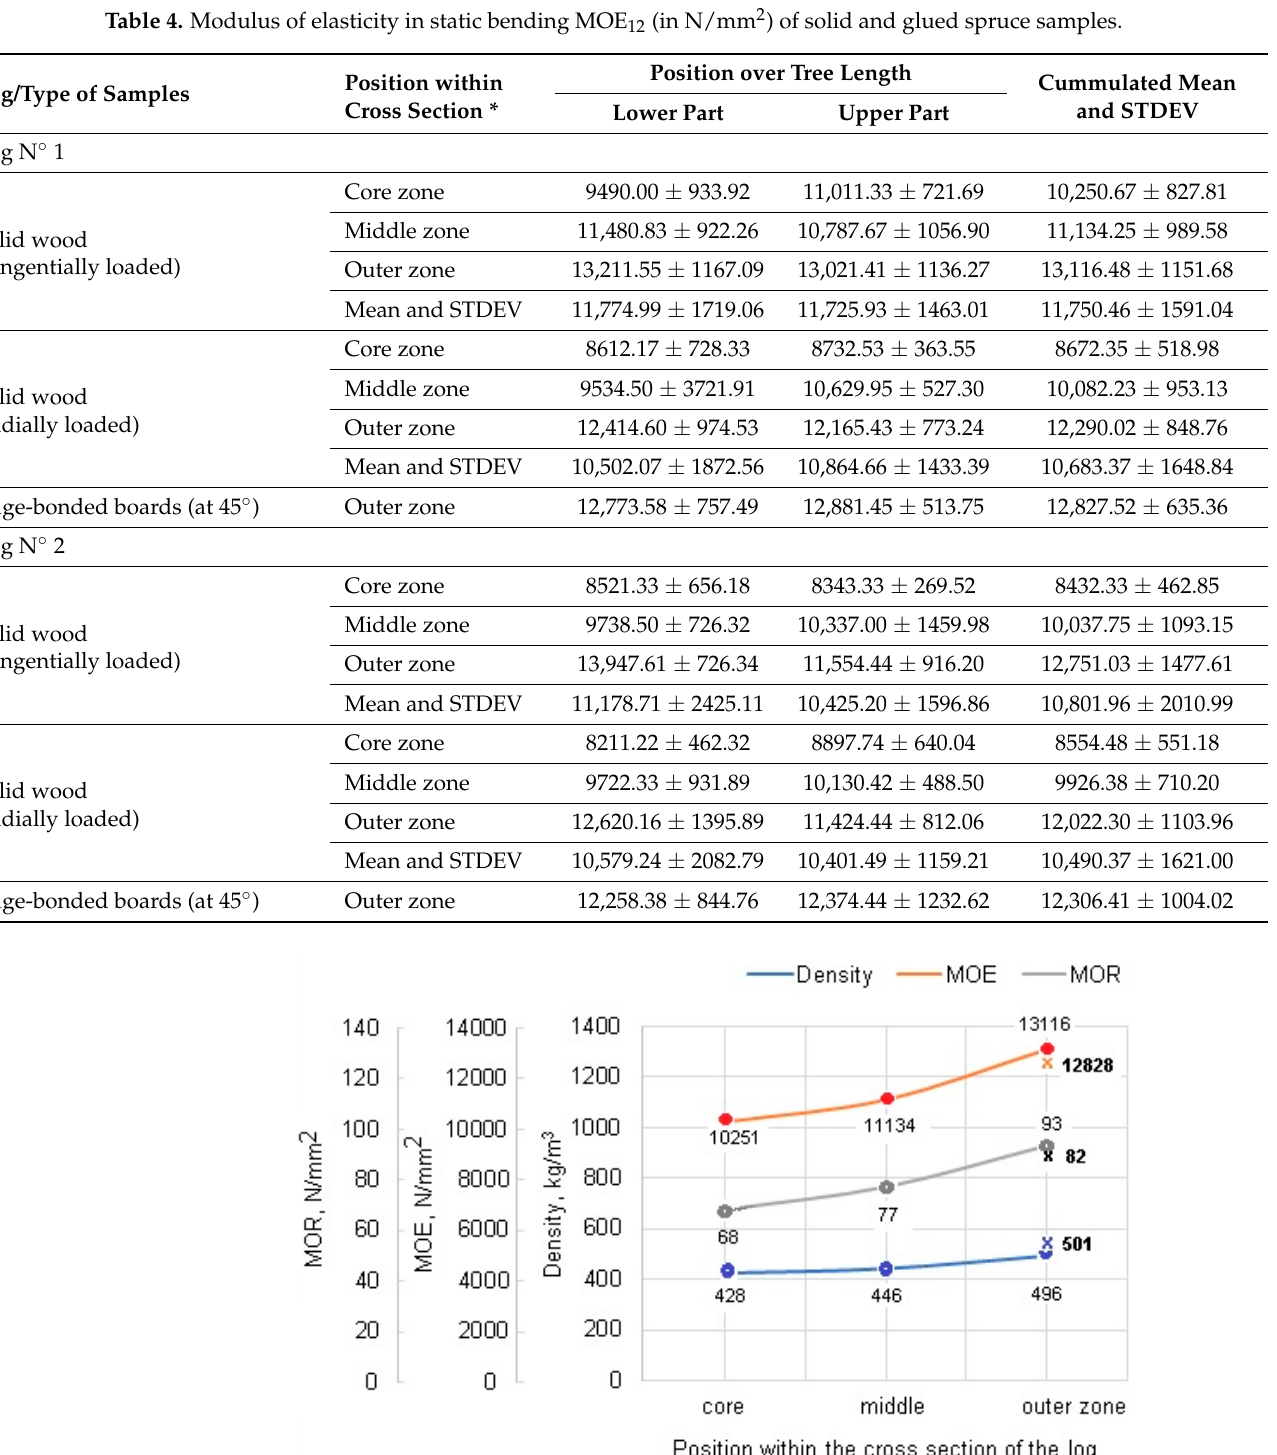
Figure 7. Variation tendency of density, MOE and MOR, over the cross section of the log, for the solid wood samples (represented with circles), compared to glued samples (represented with “x”).